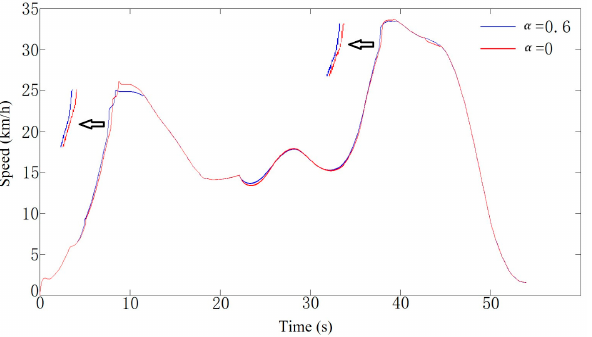
Figure 22. Comparison of actual speed of 𝛂 = 𝟎 and 𝛂 = 𝟎.𝟔 under working condition B.